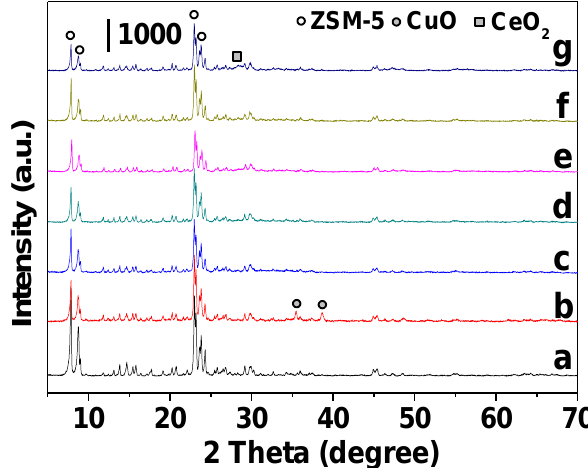
Figure 1. XRD patterns of CuCe x Zr 1 − x /ZSM-5 catalysts with different loading ratios: (a) ZSM-5, (b) Cu/ZSM-5, (c) CuZr 1 /ZSM-5, (d) CuCe 0.25 Zr 0.75 /ZSM-5, (e) CuCe 0.5 Zr 0.5 /ZSM-5, (f) CuCe 0.75 Zr 0.25 /ZSM-5, and (g) CuCe 1 /ZSM-5.